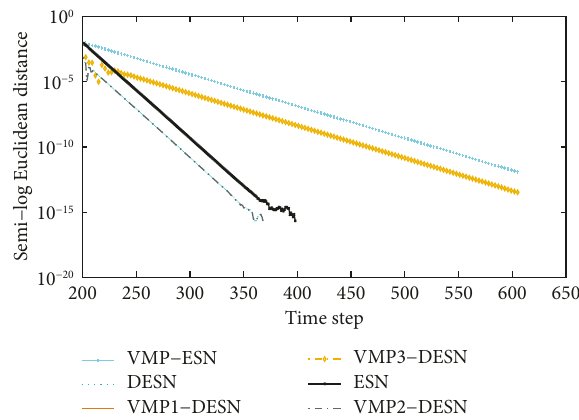
Figure 3: Euclidean distance curves comparison of six prediction models under different initial states.